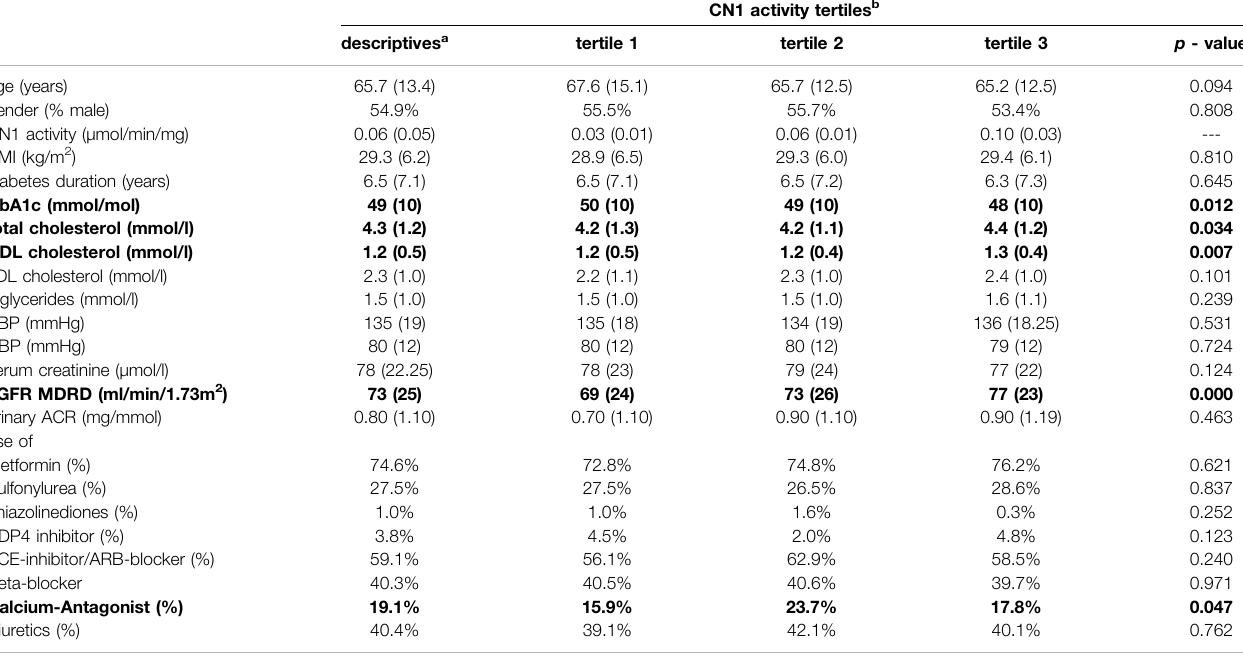
TABLE 2 | Baseline characteristics and CN1 activity